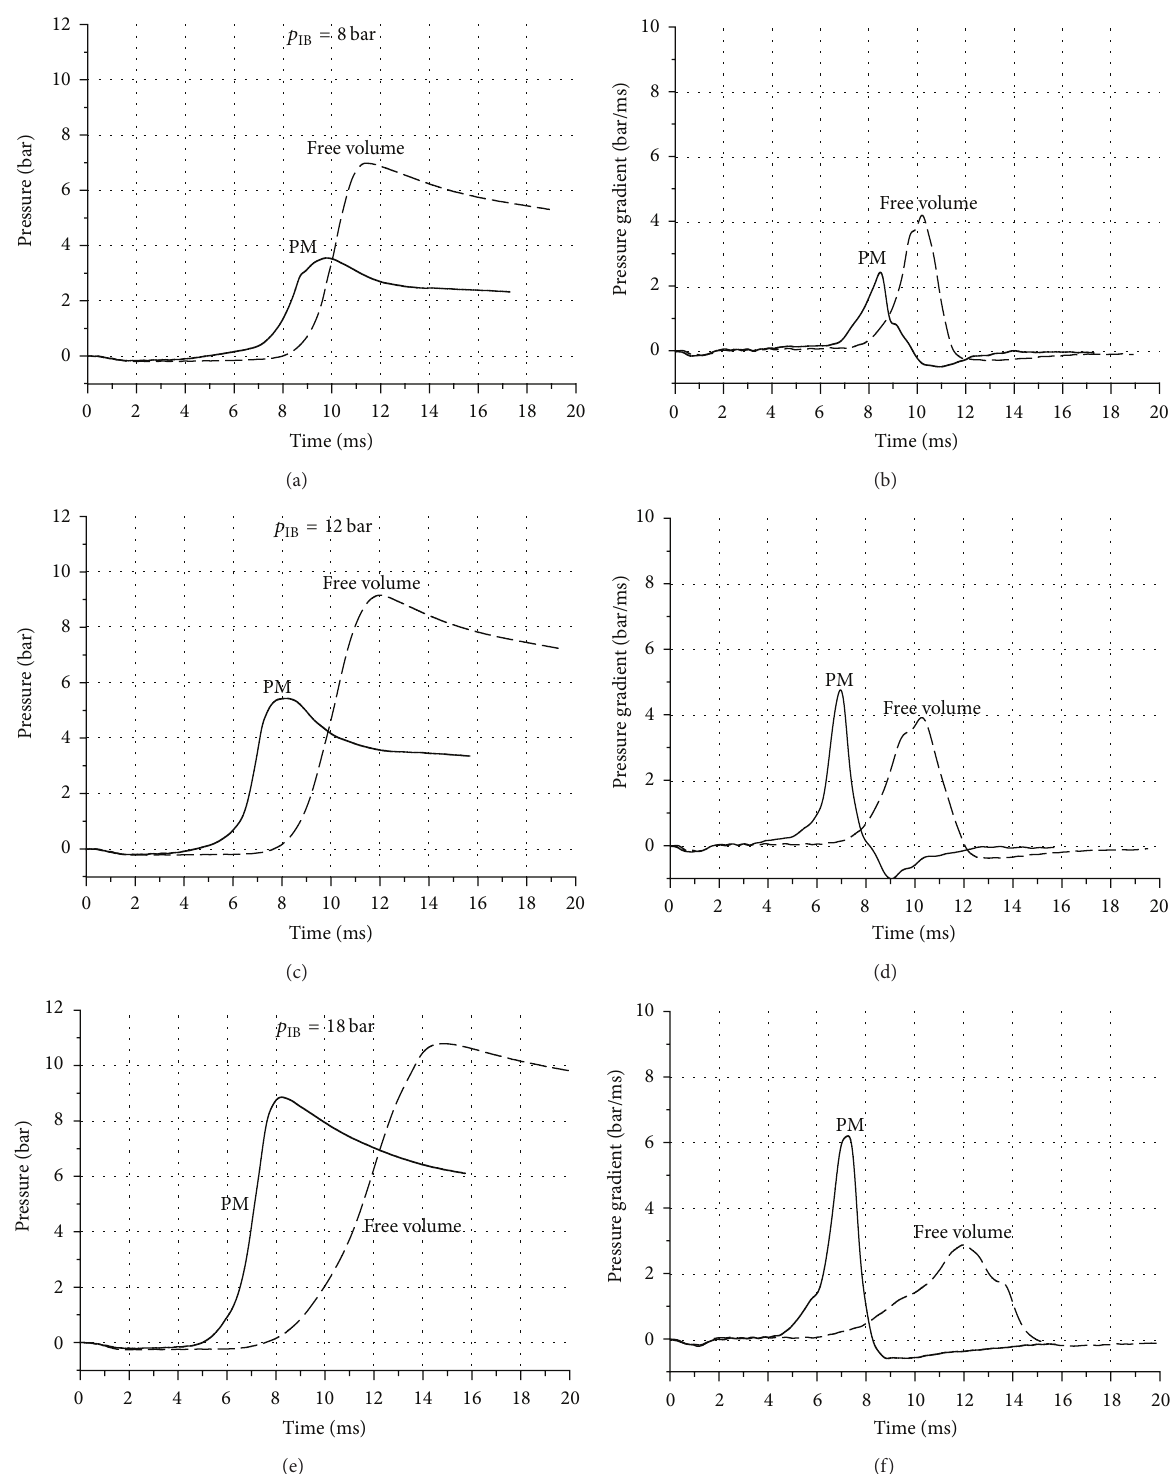
Figure 7: Comparison of pressure histories and pressure gradient distributions for heat release in free volume and in an SiC foam porous reactor (8ppi) after fuel injection startsat threeinitial pressuresand temperature 400 ∘ C.The amount of injected fuel is 23.7 mg: left—complete history; right—pressure